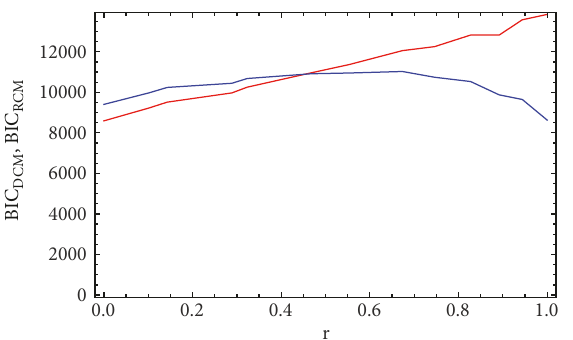
Figure 7: Comparison between the numerical values of the BIC computed for the RCM (blue trend) and the DCM (red trend) on a network with an increasing level of reciprocity 𝑟